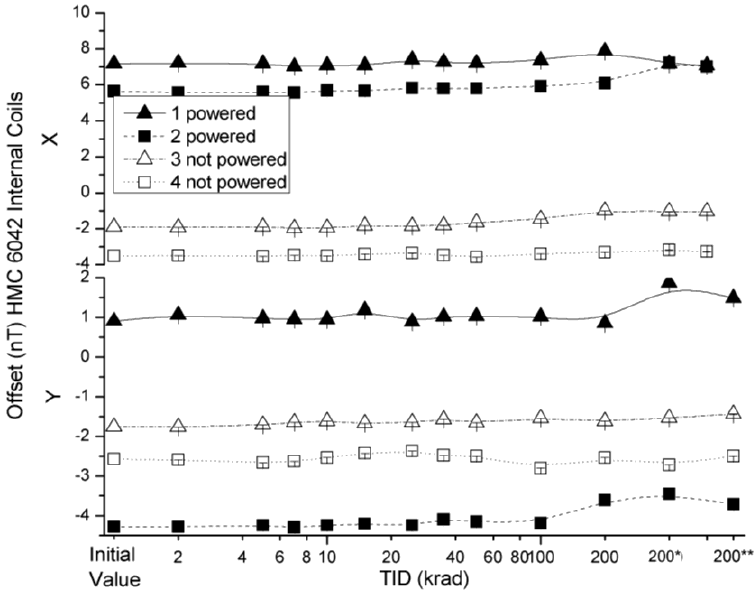
Figure 12. Measured offsets in internal coils configuration as a function of TID for powered and non-powered HMC